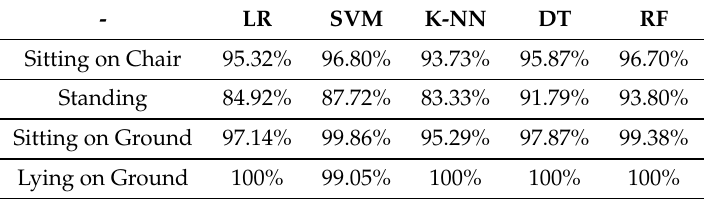
Table 12. Recall rate using different algorithms for two people.